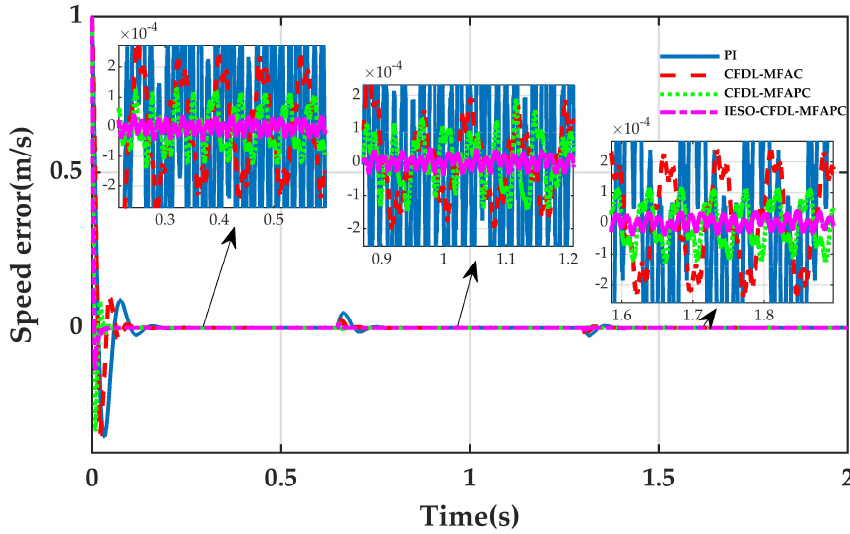
Figure 6. Speed-tracking error curves for the four control algorithms under sudden load.